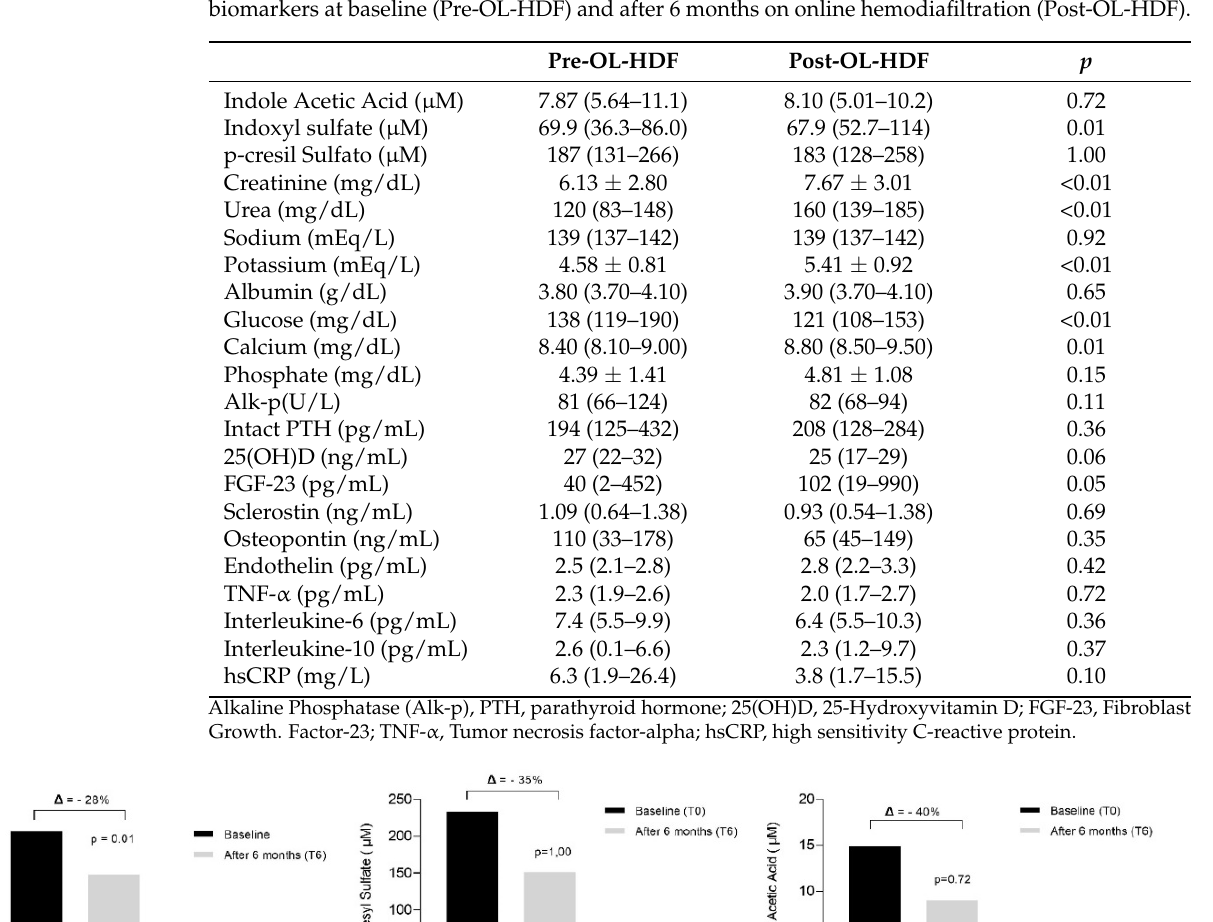
Table 2. Uremic toxins, biochemical data, bone mineral disease, endothelial and inflammatory biomarkers at baseline (Pre-OL-HDF) and after 6 months on online hemodiafiltration (Post-OL-HDF).